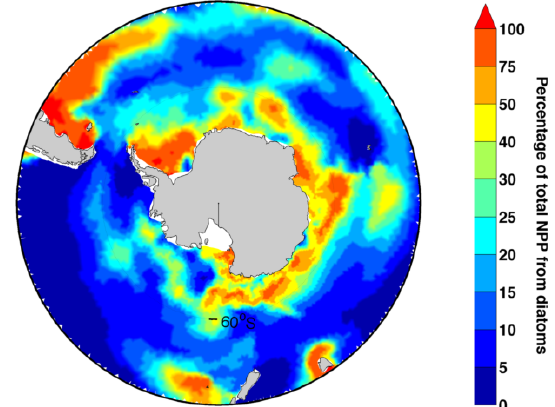
Figure 16. Contribution of diatoms to NPP in the model.